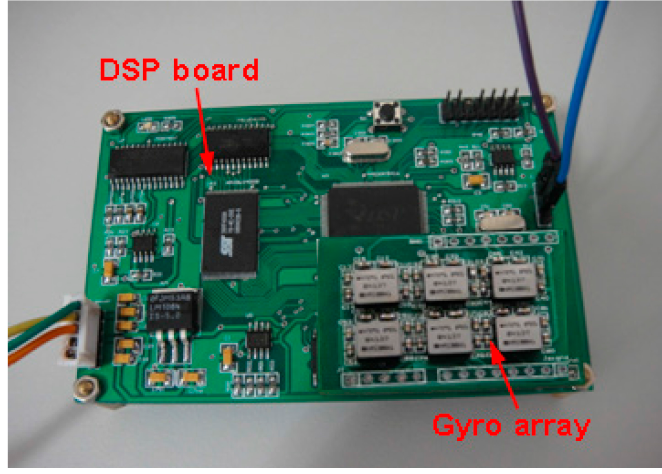
Figure 7. Prototype of the developed virtual gyroscope system.